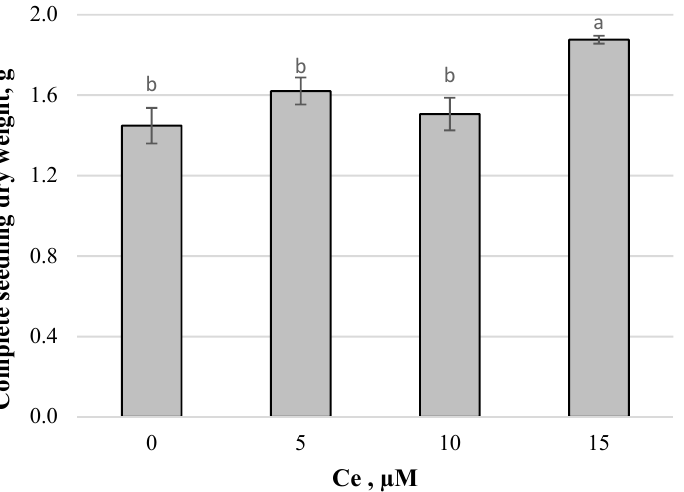
Figure 4. Complete seedling dry weight of tomato ( Solanum lycopersicum L.) cv. Vengador seedlings after seven days in germination chambers in solutions with different Ce concentrations. Means ± SDs with different letters indicate significant statistical differences (LSD, 0.05).